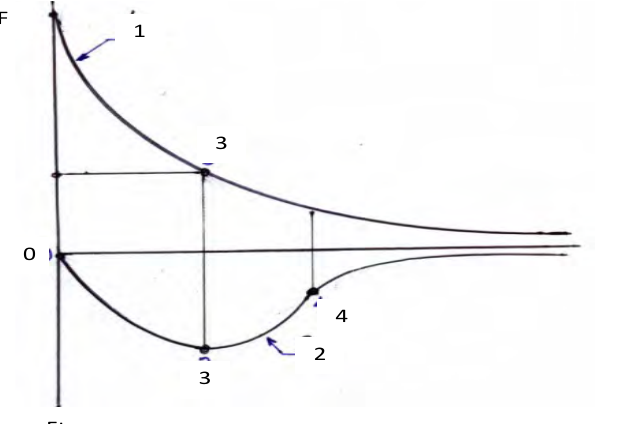
Fig.2. Graphic picture of force value dependence on intensity of impulse, generating appropriate quantity of movements. Notes: 1. Dependence curve of static tension’s intensity and duration of its conservation. 2. Curve of force impulse under different intensity of static tension. 3. Graph points corresponding o maximal force impulse and tension intensity. 4. Flex point on curve 2. Value 1/e≈1/2.72, where е =